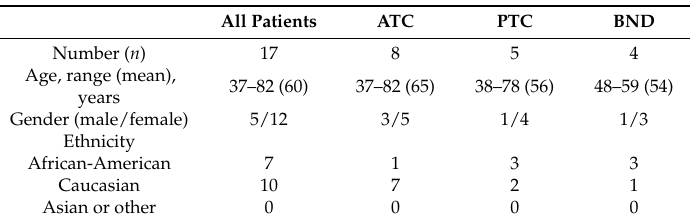
Table 1. Summary of patient characteristics.